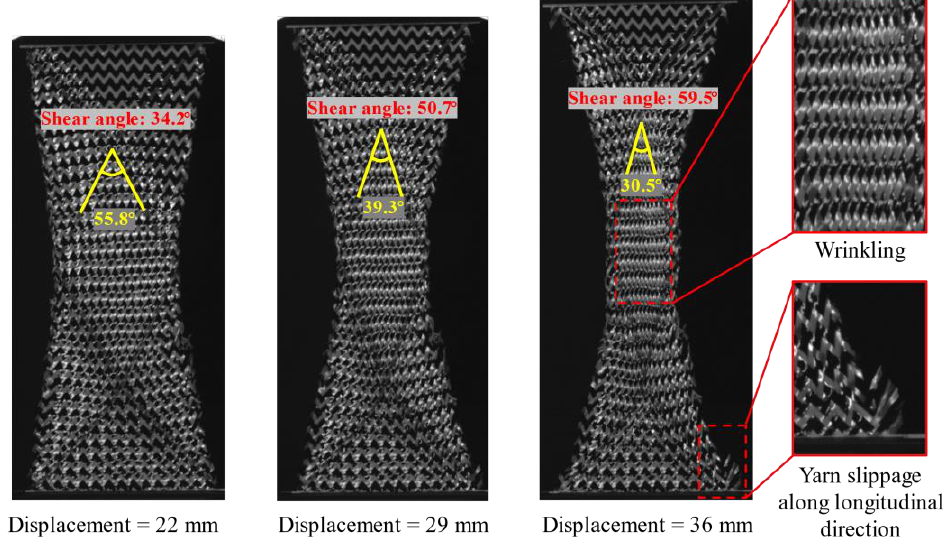
Figure 10. Shear angle evolution in the bias-extension test. The wrinkles occur at a shear angle of about 60°.